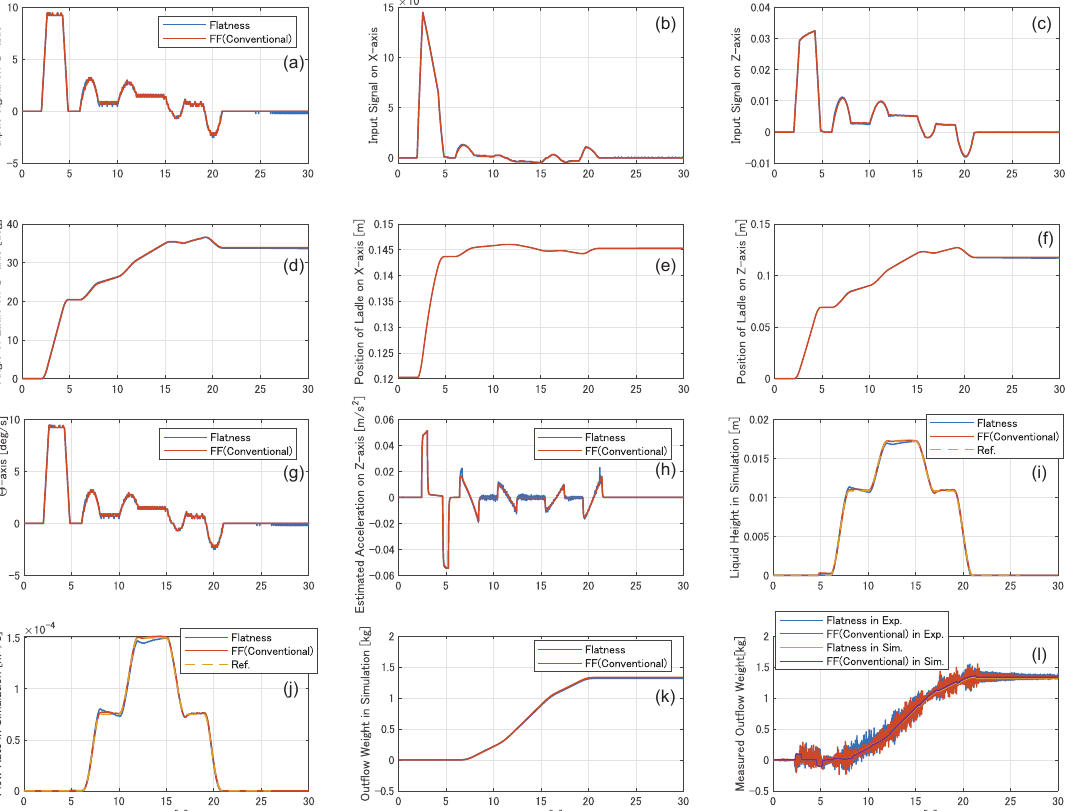
Figure 10. Experimental results of flow rate control to pouring process without disturbance. ( a ) Input signal added to motor of the Θ -axis. ( b ) Input signal added to motor of the X -axis. ( c ) Input signal added to motor of the Z -axis. ( d ) Angle of tilting ladle on Θ -axis. ( e ) Position of ladle on X -axis. ( f ) Position of ladle on Z -axis. ( g ) Angular velocity on Θ -axis, estimated by steady-state Kalman filter. ( h ) Acceleration on Z -axis, estimated by steady-state Kalman filter. ( i ) Liquid height at pouring mouth in simulation, using pouring model. ( j ) Flow rate of outflow liquid in simulation, using pouring model. ( k ) Weight of outflow liquid in simulation, using pouring model. ( l ) Weight of outflow liquid, measured by load